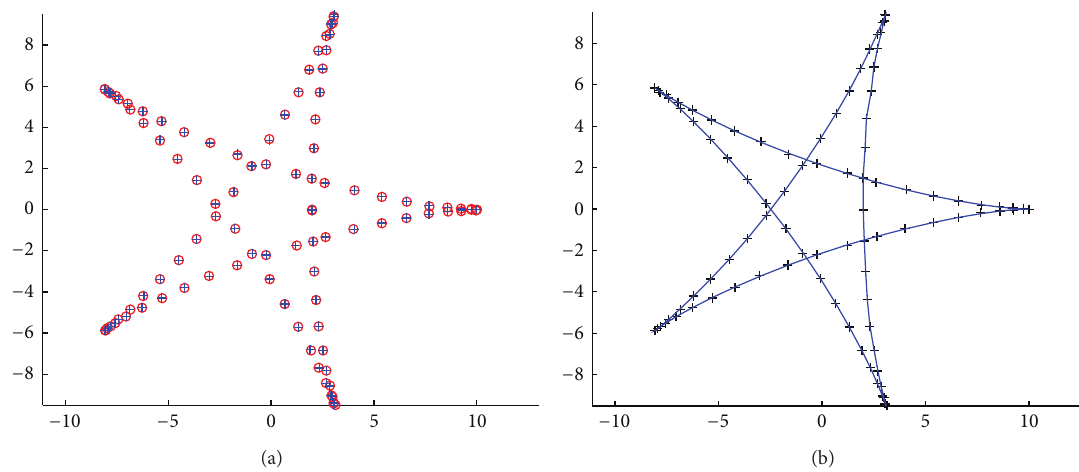
Figure 3: Application of the cuckoo search algorithm to the hypocycloid curve example: (a) original data points (red emptied circles) and reconstructed points (in blue plus symbol); (b) data points (black plus symbol) and fitting curve (solid blue